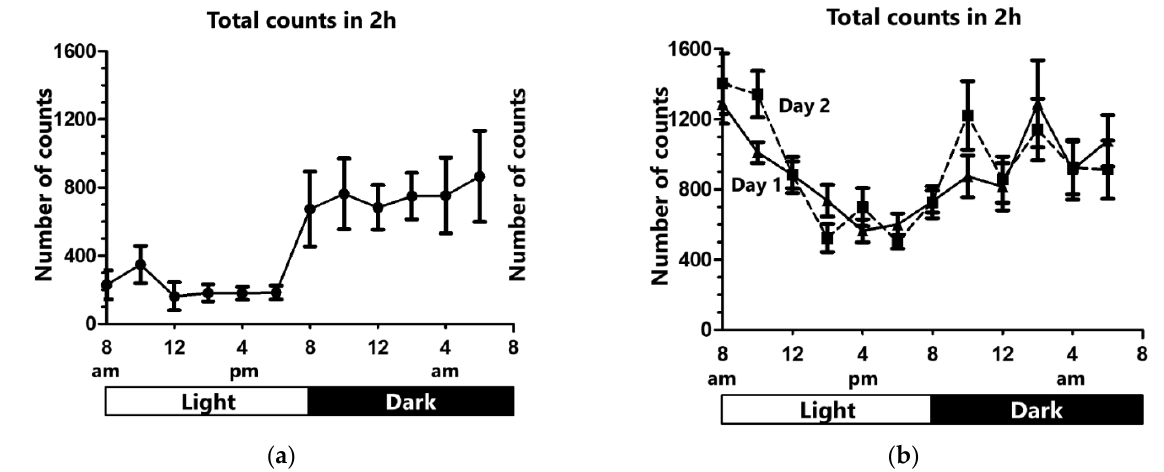
Figure 1. Total ‘counts’ measured by the actigraph unit. ( a ) Under the control condition, total counts were lower during the light cycle, and higher during the dark cycle, indicating a sleep phase in the light and an awake phase in the dark. ( b ) In the sleep deprivation cage, the activity of the rats was higher compared with the control condition. Total counts did not differ significantly between day 1 and day 2. Data are shown as mean ± standard error of means.